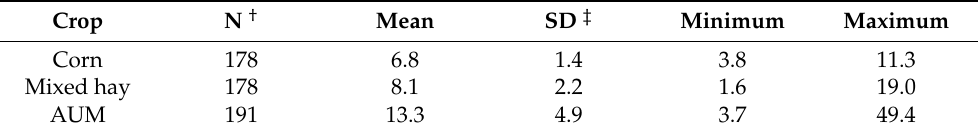
Table 1. Mean and distribution of expected yield (MT · ha − 1 ) for corn, mixed hay (grass–legume hay), and animal unit months of grazing (AUM · ha − 1 ) for West Virginia soil components as reported in the National Soils Information System as of August 2020.